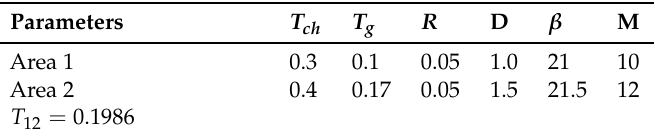
Table 1. Parameters of concerned systems.